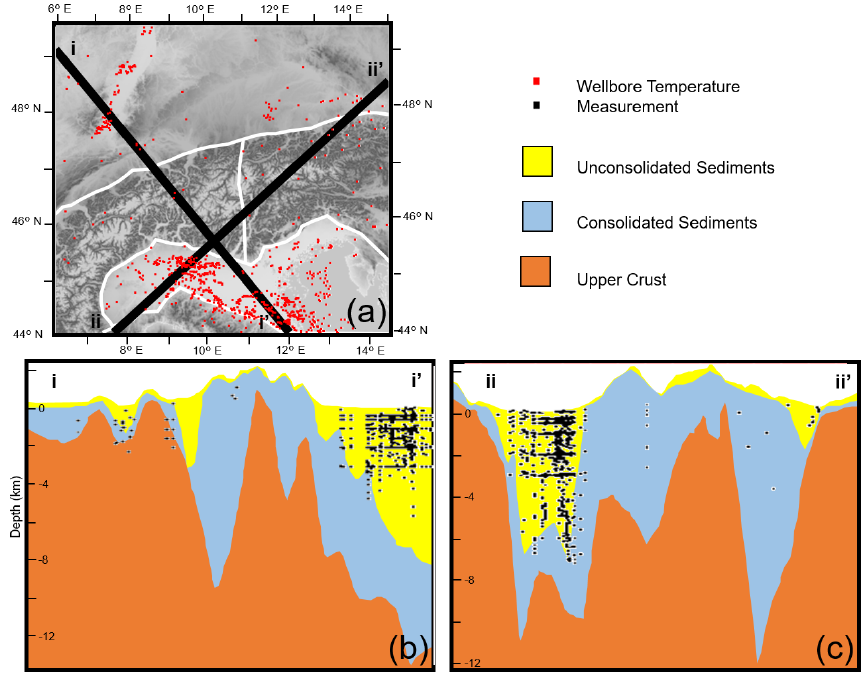
Figure 2. Spatial distribution of the temperature measurements (a) projected on the surface, (b) along the cross section (i), and (c) along the cross section